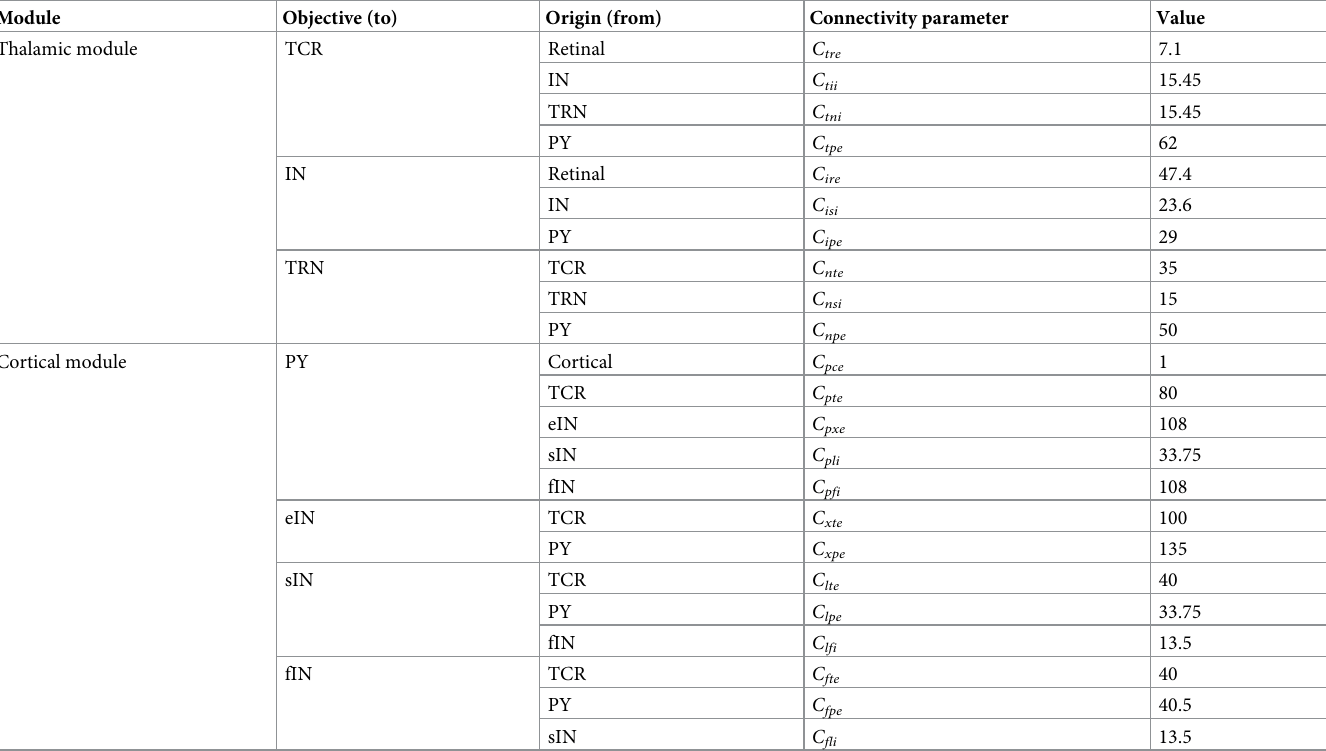
Table 1. Parameters of synaptic connection between different neuron populations in the model. Module